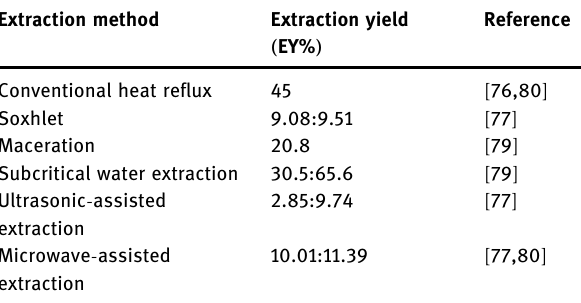
Table 2: Yield values of the extracts of WS prepared using di ff erent extraction techniques Extraction